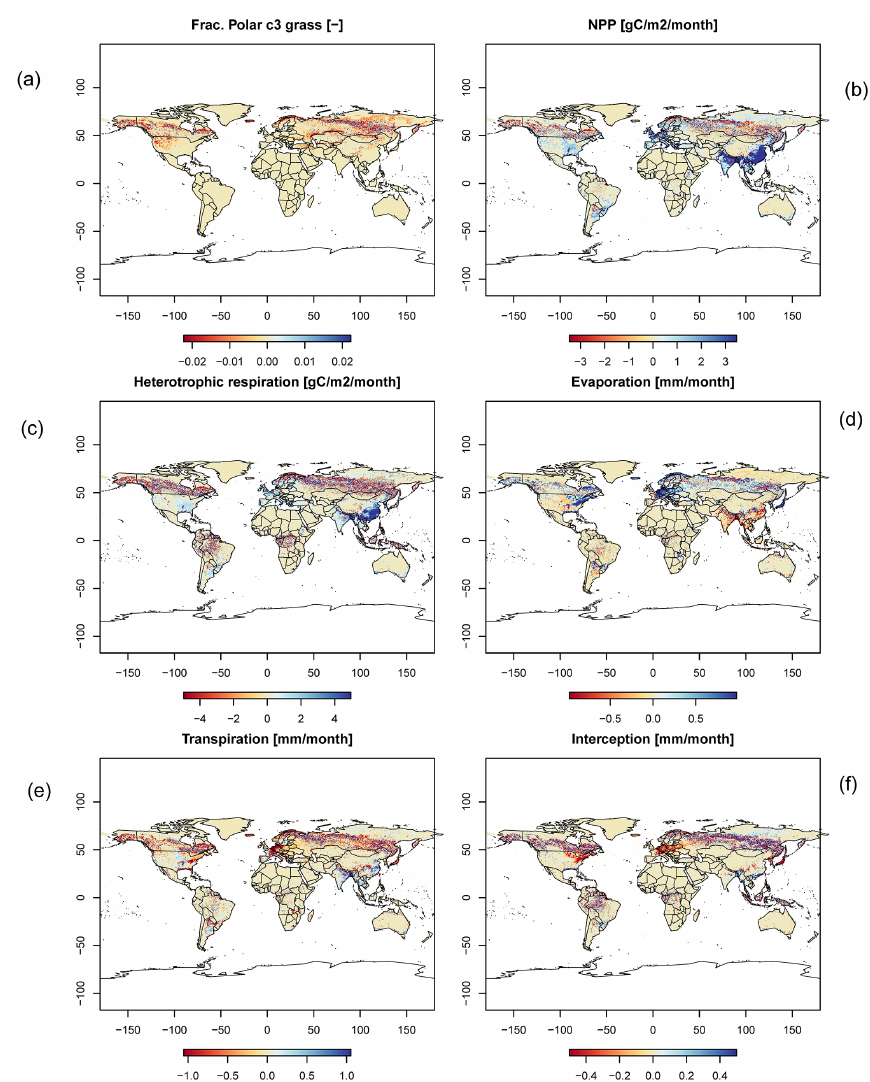
Figure C5. Difference maps of (a) frac. polar C 3 grass, (b) NPP, (c) heterotrophic respiration, (d) evaporation, (e) transpiration, and (f)